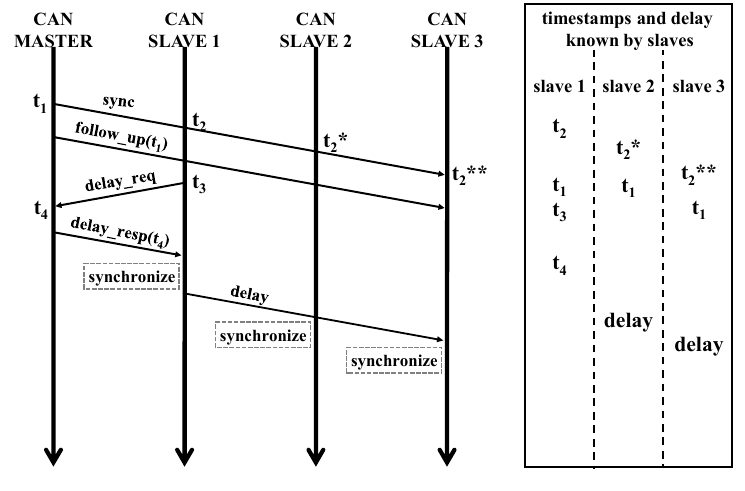
Figure 5. Synchronizing process for sharing the delay.